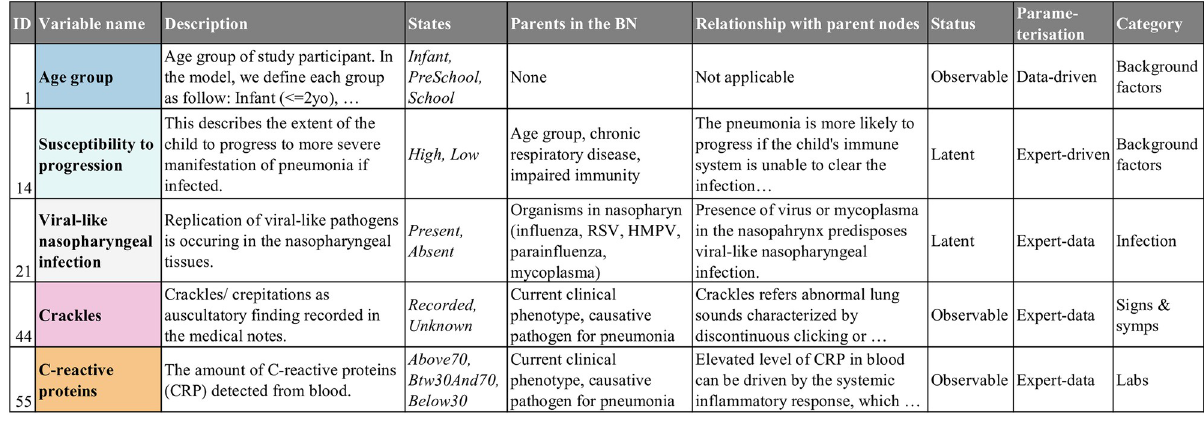
Fig 3. Extract from the BN dictionary. The full dictionary is provided in S1